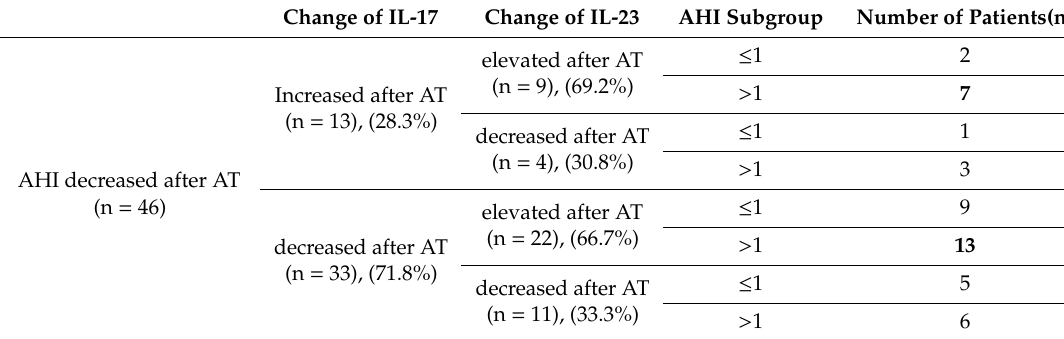
Table 4. The association between AHI, IL-17, and IL-23 (cuto ff point: AHI > 1). Change of IL-17 Change of IL-23 AHI Subgroup Number of Patients(n) elevated after AT (n = 9), (69.2%) Increased after AT (n = 13), (28.3%) decreased after AT (n = 4), (30.8%) AHI decreased after AT (n = 46) elevated after AT (n = 22), (66.7%) decreased after AT (n = 33), (71.8%) decreased after AT (n = 11), (33.3%)